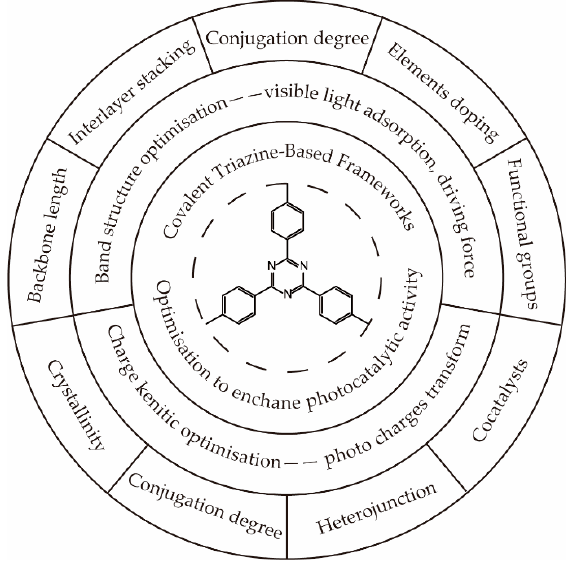
Figure 9. Functionalized optimization of the covalent triazine-based